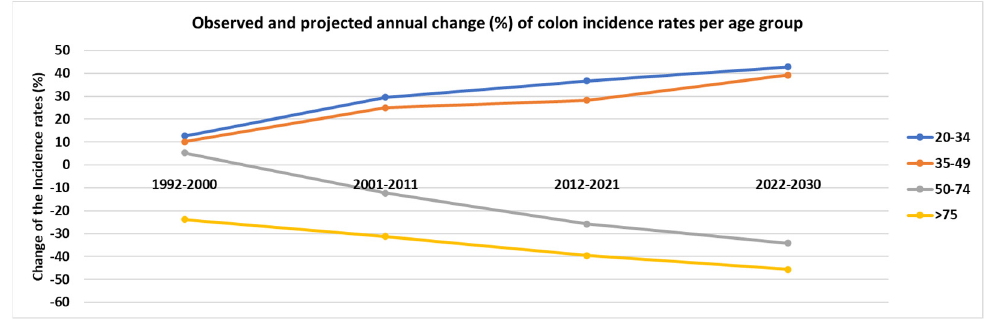
Figure 2. Observed and projected annual change (%) of colon cancer incidence rates per age group.